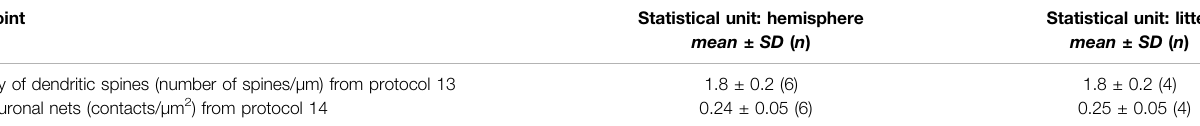
Statistical unit: litter mean ± SD ( n ) mean ± SD ( n )